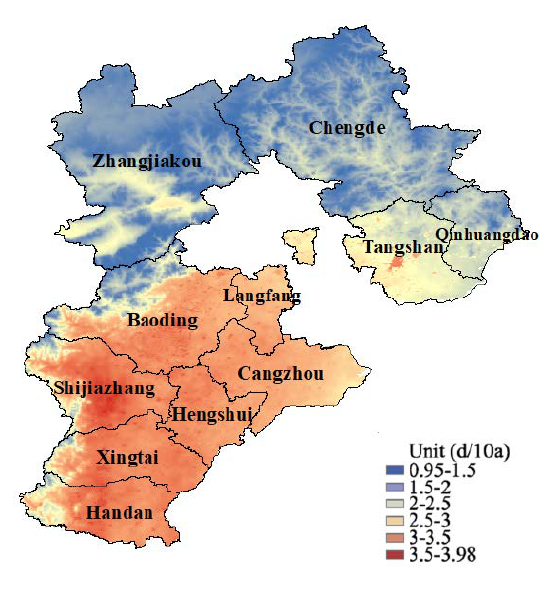
Fig. 4 Agricultural impact assessment of heavy rain disaster in Hebei Province from 08:00 on July 18 to 08:00 on